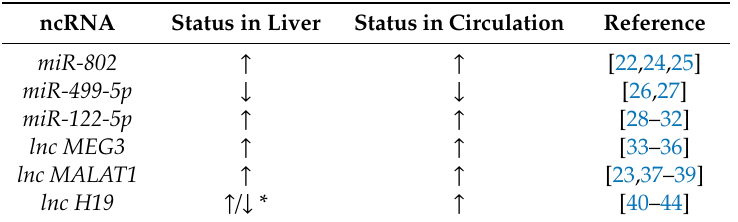
Table 1. Circulating non-coding RNA (ncRNAs) altered in hepatic insulin